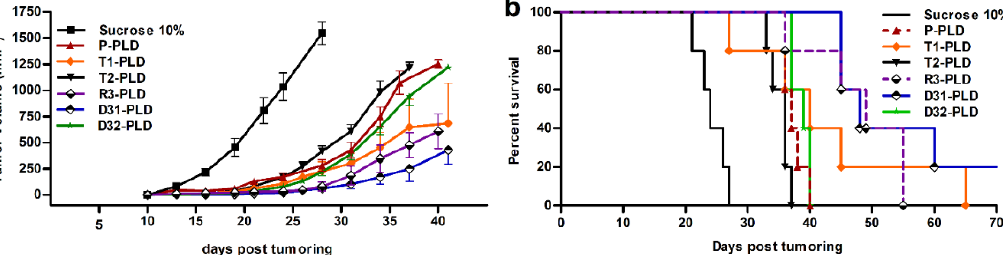
Figure 9. Therapeutic efficacy of various liposomal preparations: ( a ), tumor growth rate and ( b ), survival curve of female C57 mice bearing B16 tumors after an IV administration of 15 mg/kg of liposomal doxorubicin or sucrose 10% on day 10 after tumor inoculation. Data represented as mean ± SD ( n = 5).